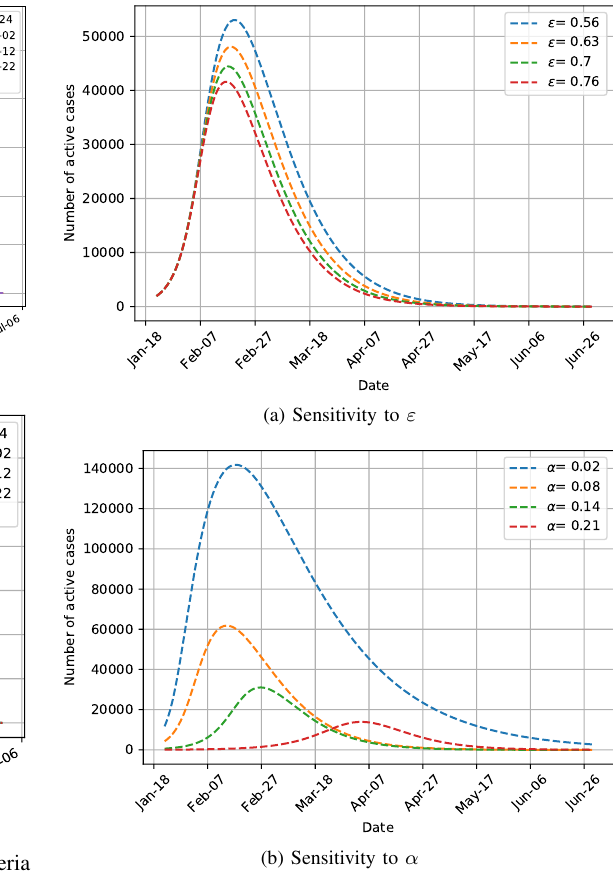
Fig. 4: Effect of the timing of the relaxation of the criteria for screening, i.e., of the change from α r to α m . All dates in 2020. (a) Number of detected active cases. (b) Percentage of undetected cases among infected individuals.